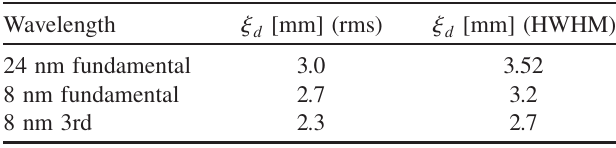
at the detector d